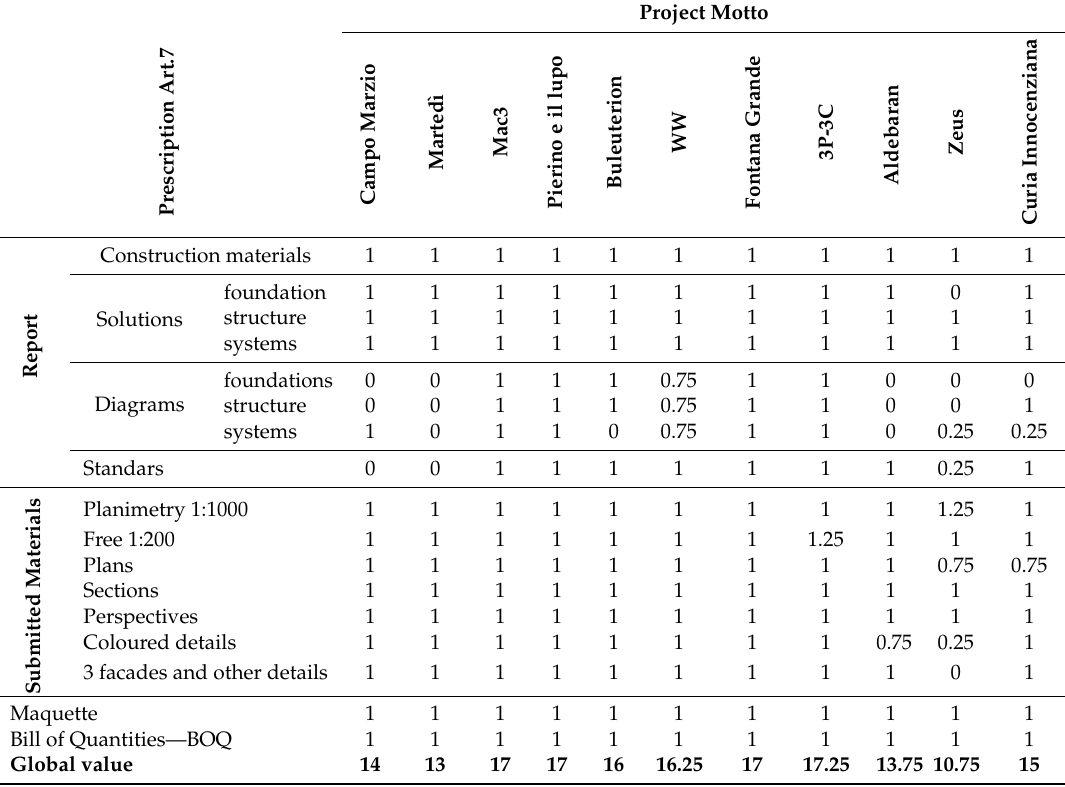
Table 6. Example of the quantitative criterion: “Relevance to the rules (art. 7)”—translation in numbers of data of 1967 committee.